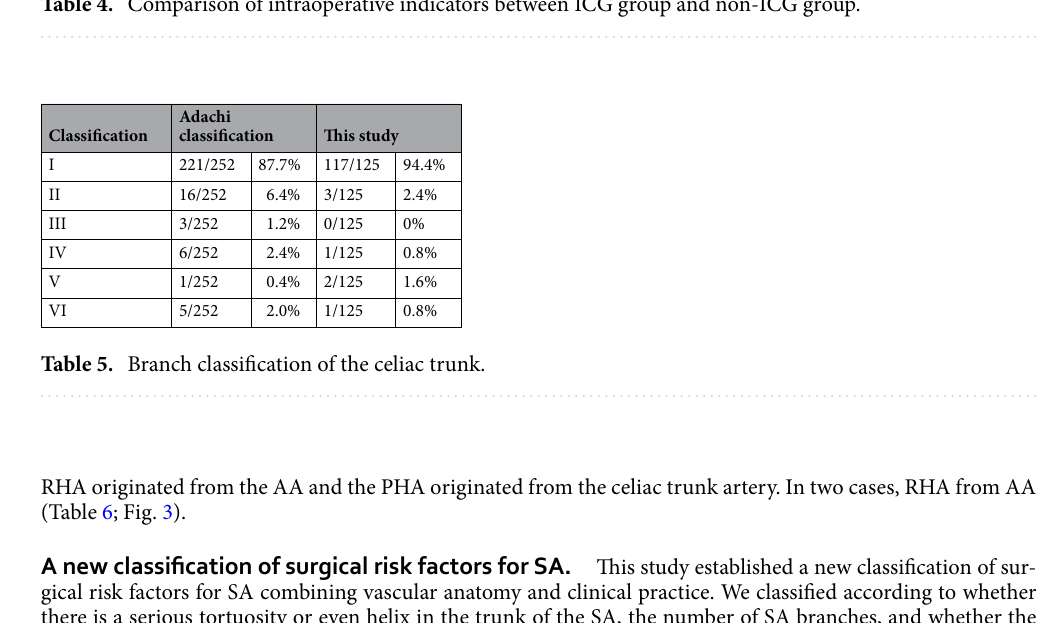
Table 4. Comparison of intraoperative indicators between ICG group and non-ICG group.